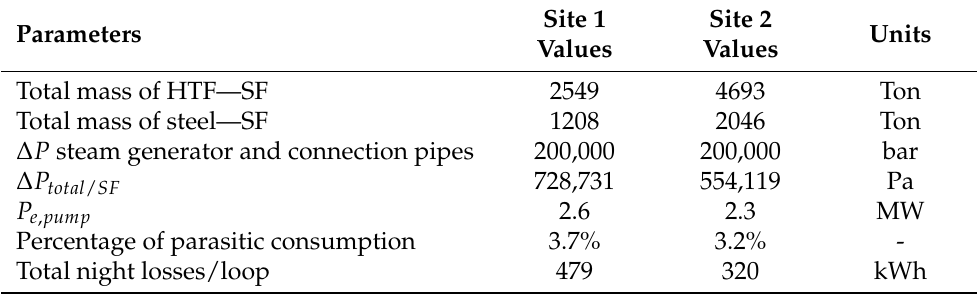
Table 8. Loss of charge and parasitic